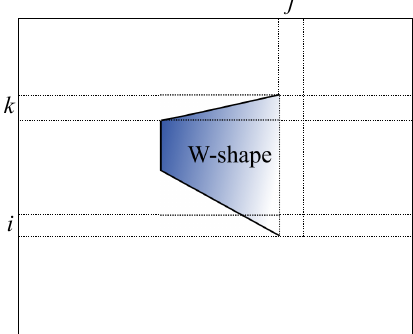
Figure 6. Sequential computation with position indices i , j , k .